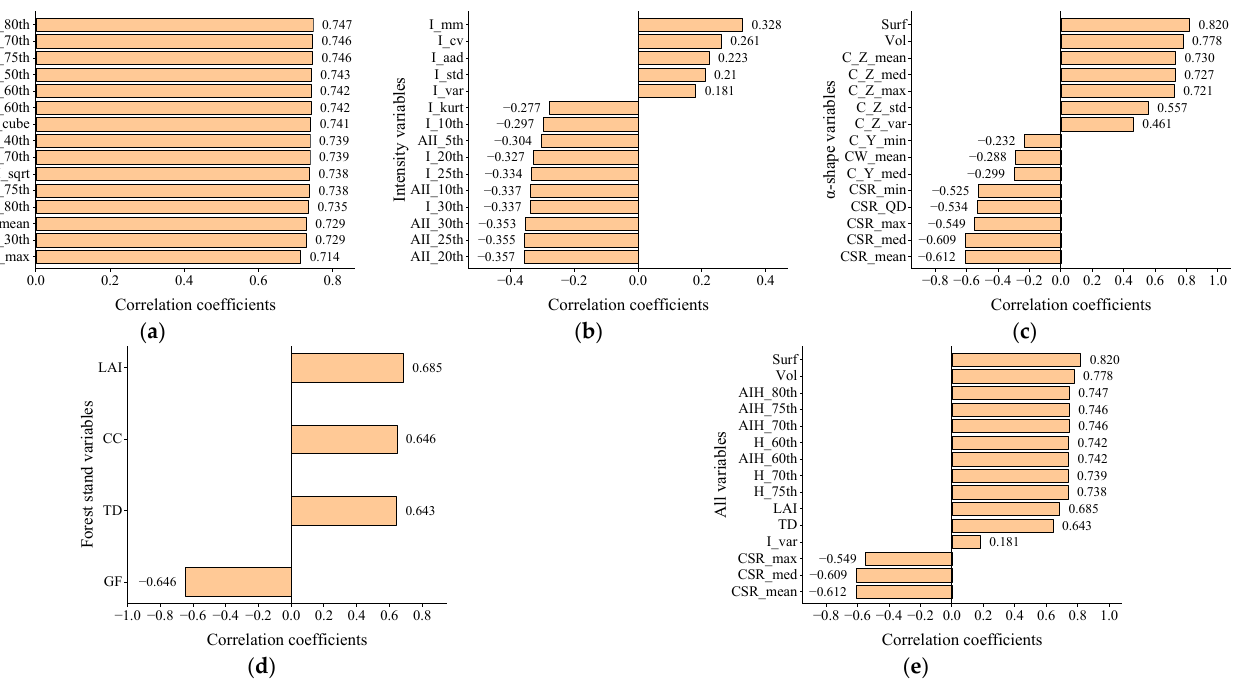
Figure 4. Features correlation of each group features: ( a ) Height metrics; ( b ) Intensity metrics; ( c ) Alpha-shape metrics; ( d ) Stand metrics; ( e ) Mixed metrics.